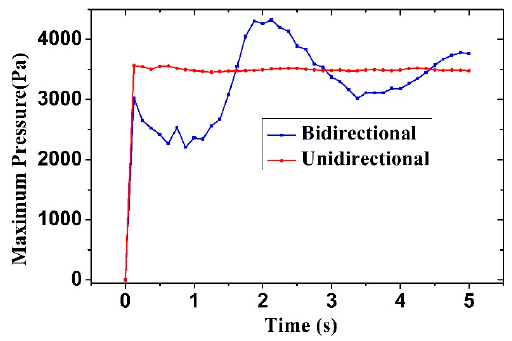
Figure 15. Maximum pressure variation with time.